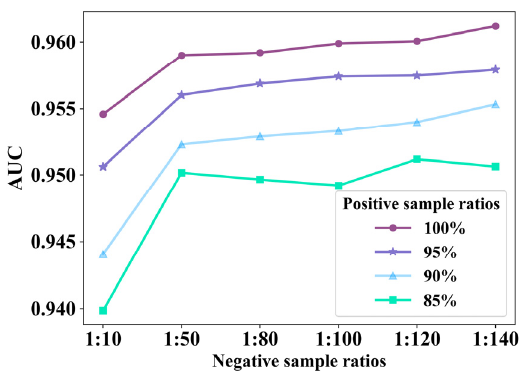
Figure 6. Results of EMPHCN under different negative sample ratios and different positive sample ratios on dataset T2.